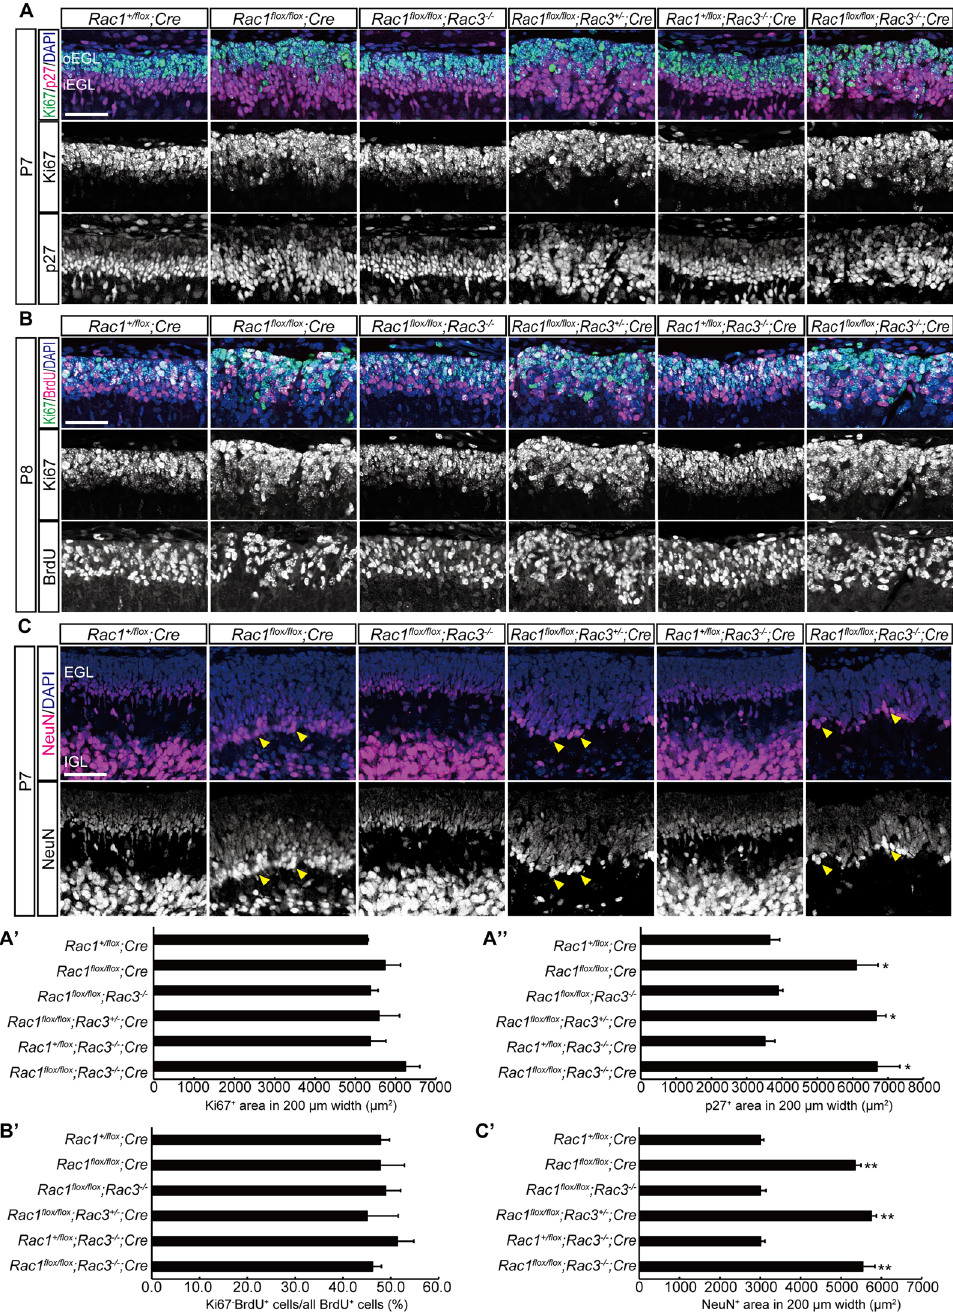
Figure 3. Thickness of the iEGL was increased in Rac1 flox/flox ; Cre , Rac1 flox/flox ; Rac3 +/− ; Cre and Rac1 flox/flox ; Rac3 −/− ; Cre mice due to impaired migration of NeuN-positive cells. ( A ) Immunohistochemistry for Ki67 and p27 of the sagittal section of the anterior part of the lobule IV on P7. ( B ) Immunohistochemistry for BrdU and Ki67 of the sagittal section of the anterior part of the lobule IV. Mice were injected with BrdU on P7 and sacrificed 24 h after the injection (P8). ( C ) Immunohistochemistry for NeuN of the sagittal section of the anterior part of the lobule IV on P7. Immunopositive signal of NeuN was strong in granule neurons in the IGL but weak in those in the EGL in Rac1 + /flox ; Cre , Rac1 flox/flox ; Rac3 −/− and Rac1 + /flox ; Rac3 −/− ; Cre mice. Some NeuN-positive cells in the EGL showed strong immunoreactivity in Rac1 flox/flox ; Cre , Rac1 flox/flox ; Rac3 +/− ; Cre and Rac1 flox/flox ; Rac3 −/− ; Cre mice (arrowheads). ( A ′ and A ″ ) The oEGL area occupied by Ki67-positive cells was not different among genotypes, whereas the iEGL area occupied by p27-positive cells was significantly increased in Rac1 flox/flox Cre , Rac1 flox/flox ; Rac3 +/− ; Cre and Rac1 flox/flox ; Rac3 −/− ; Cre mice. ( B ′ ) Cell-cycle exit was not affected by Rac depletion/deletion. The proportion of cells that exit the cell cycle (BrdU + /Ki67 - ) among all BrdU + cells was not changed among genotypes. ( C ′ ) The area occupied by NeuN-positive cells was significantly increased in Rac1 flox/flox Cre , Rac1 flox/flox ; Rac3 +/− ; Cre and Rac1 flox/flox ; Rac3 −/− ; Cre mice. Each bar represents mean + SD (n = 3). * P < 0.05, ** P < 0.01 (significantly different from Rac1 + /flox ; Cre mice), one-way ANOVA followed by a Tukey’s post hoc test. Scale bars, 50